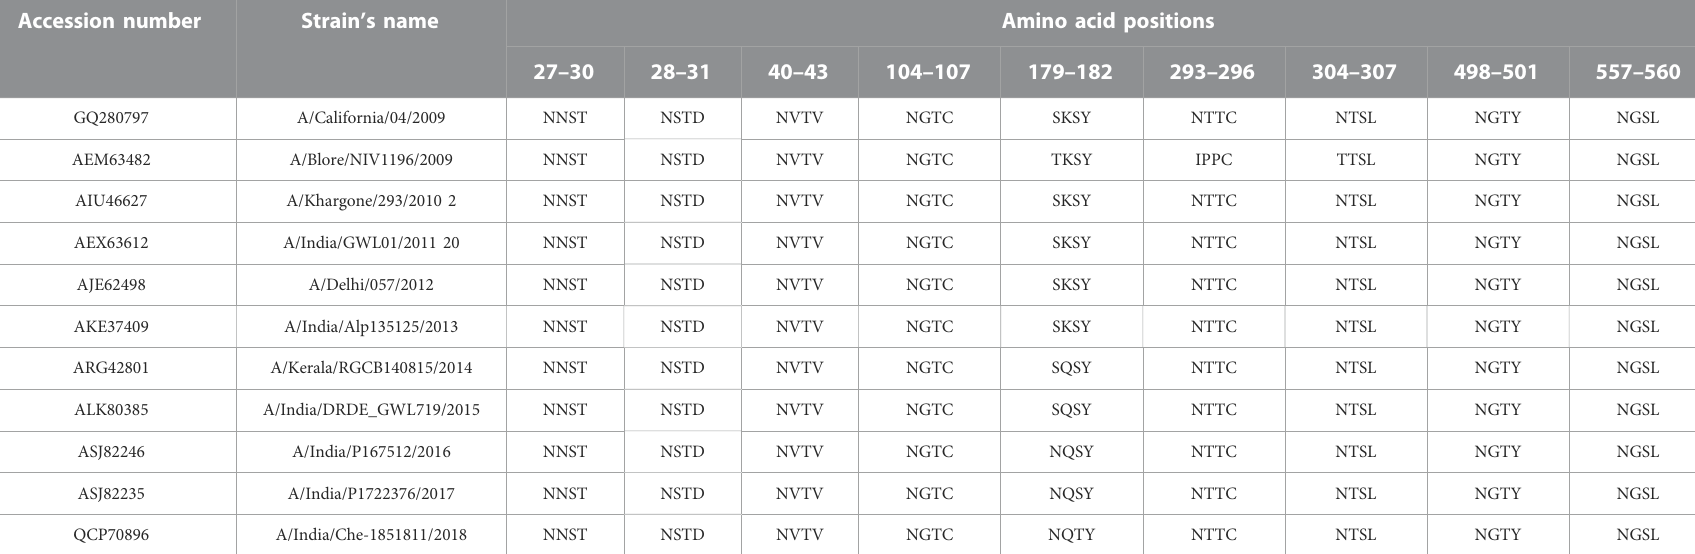
TABLE 6 Predicted N-glycosylation sites of HA Ind compared with the reference HA Cal proteins. The newly emerged N-glycosylation sites (amino acids in 179 – 182 positions), speci fi c to HA Ind strains, are shown in